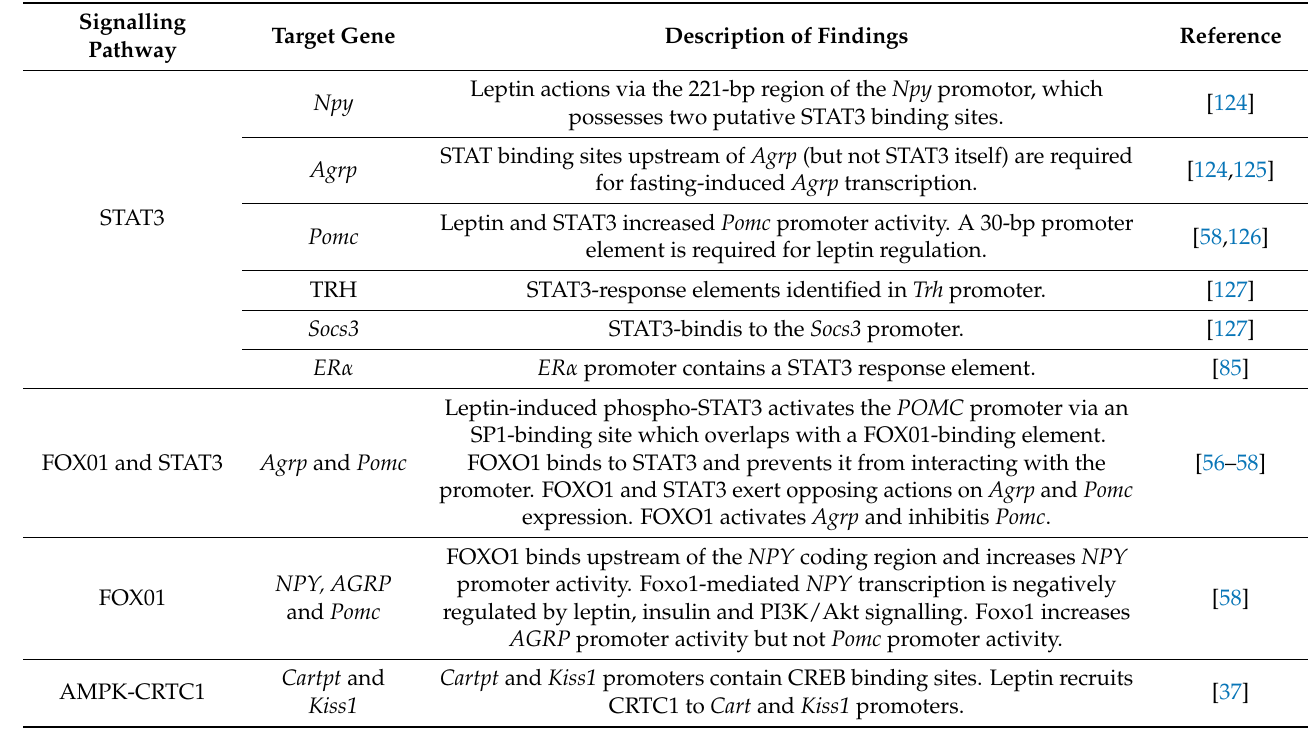
Table 2. Evidence for direct promotor binding and transcriptional activity of leptin signalling molecules on target genes relevant to metabolic and reproductive function. See Figure 1 legend for abbreviations of signalling